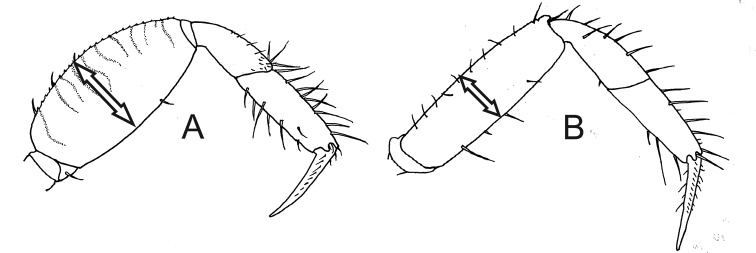
Last ambulatory legs, posterior view. AMinuca
rapax, wide merus (seta). BMinuca
burgersi, narrow merus (seta).